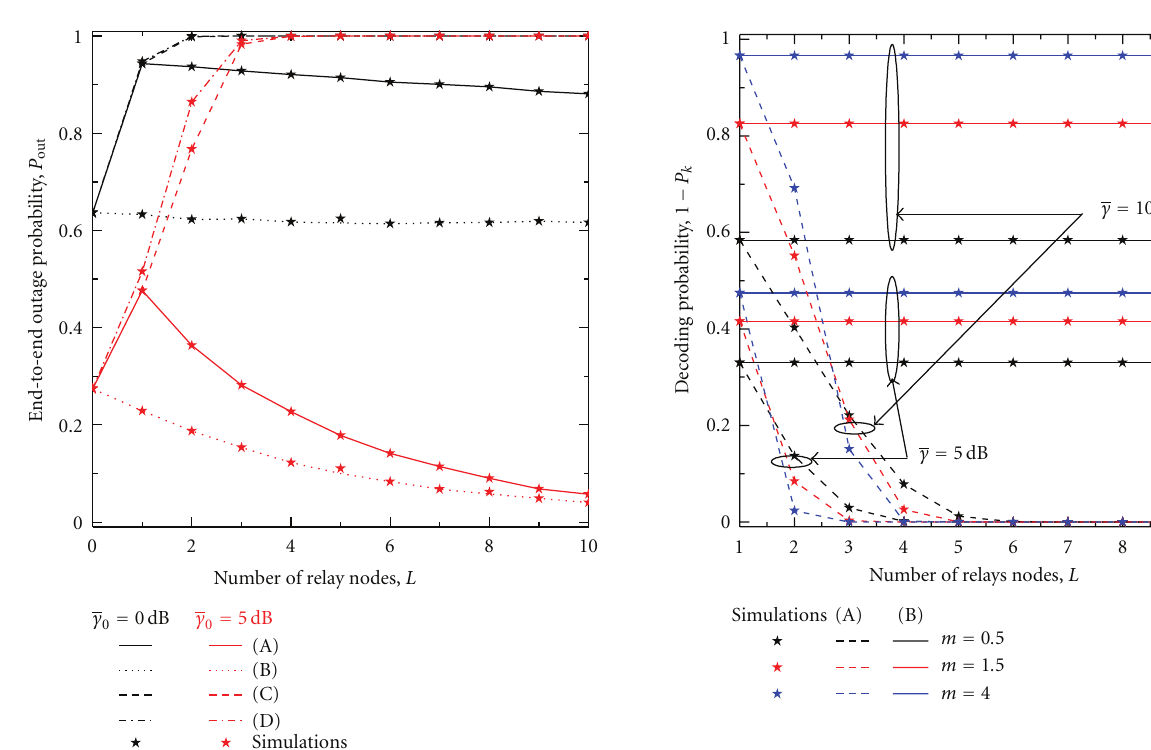
Figure 4: Decoding probability, 1 − P k , versus the number of relay nodes, L , over IID Nakagami- m fading channels with di ff erent = γ for all k , L : (A) repetitive and (B) RS-based values of m and γ L + k transmission.